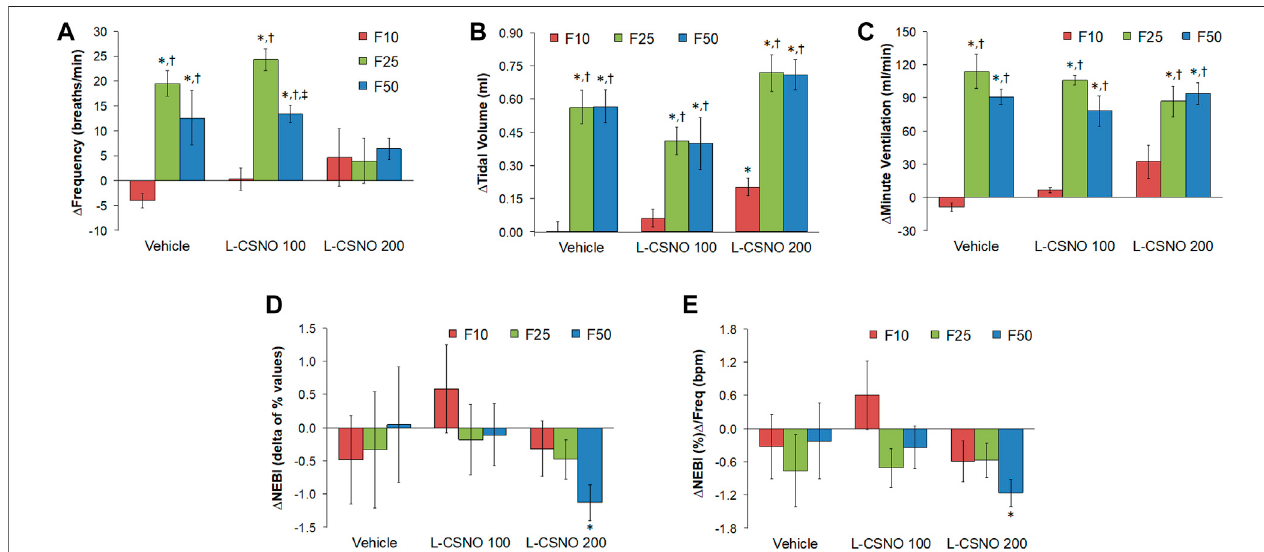
FIGURE 5 | Arithmetic changes in Pre values (i.e., those prior to any drug administration) from values just before injection of fentanyl at F10 (10 μ g/kg, IV), F25 (25 μ g/kg, IV), and F50 (50 μ g/kg, IV) in rats that were receiving infusion of vehicle (20 μ l/min, IV), L-CSNO 100 (S-nitroso-L-cysteine, 100 nmol/kg/min, IV) or L-CSNO 200 (S-nitroso-L-cysteine, 200 nmol/kg/min, IV). (A) Frequency ofbreathing. (B) Tidalvolume. (C) Minute ventilation. (D) Non-eupneic breathing index (NEBI). (E) NEBI/ Frequency of breathing (NEBI/Freq). The data are presented as mean ± SEM. There were 8 rats in each group. * p < 0.05, signi fi cant change from Pre values. † p < 0.05, F25 or F50 versus F10. ‡ p < 0.05, L-CSNO 200 versus L-CSNO